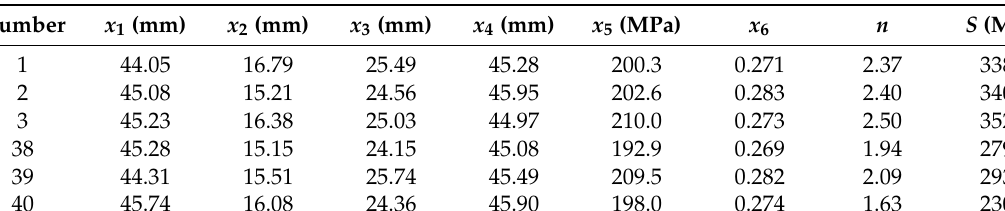
Figure 4. Contour of vonMises stress under bending due to horizontal loading (unit: MPa). Table 6. Sample data and corresponding responses.